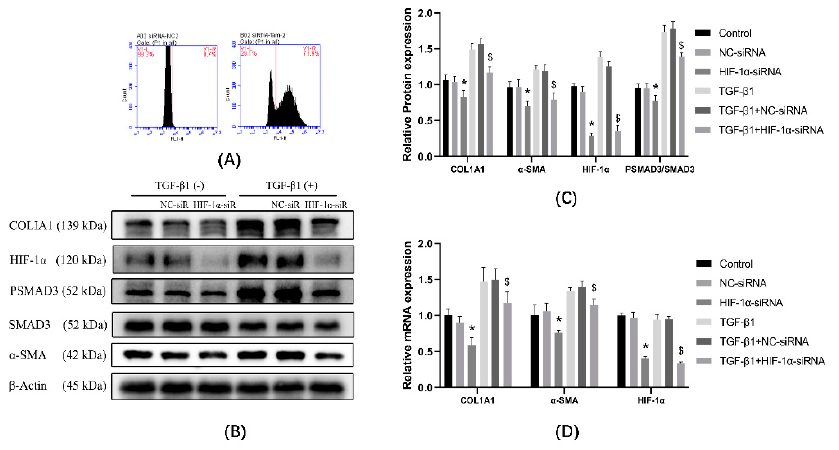
Figure 5. Cells were treated with NC-siRNA and HIF-1 α -siRNA in the presence or absence of TGF- β 1 and changes in mRNA and protein were examined to infer the degree of transdifferentiation. ( A ) Using flow cytometry, cell fluorescence intensity (transfection of siRNA that does not carry fluores- cent groups) was measured, and 99.3% of the fluorescence intensity range was set as the threshold value (below which the cells were considered not to carry fluorescent groups), and transfection ef- ficiency was calculated based on this threshold value. According to the threshold, cells exceeding the threshold were identified as successfully transfected with HIF-1 α -siRNA (carrying fluorescent moieties). (HIF-1 α -siRNA transfection efficiency was 71.9%) ( B ) Western blot analysis of COL1A1, HIF-1 α , α -SMA, SMAD3, and PSMAD3 in cells of different groups. β -actin was used as loading con- Figure 5B. ( D ) mRNA was extracted from the different groups, determined by qPCR, and normalized to β -actin. * p < 0.05 vs. NC-siRNA group; $ p < 0.05 vs. TGF- β 1 + NC-siRNA group. Results are expressed as means ± SD. ANOVA was used to compare multiple groups and pairwise comparisons were compared by LSD-t test. A value of p < 0.05 was considered to be statistically